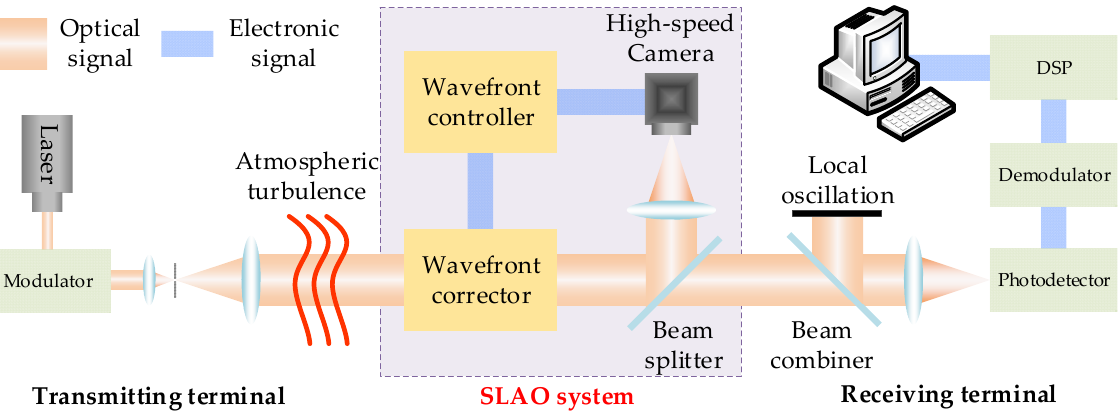
Figure 1. Typical CFSOC system with SLAO.